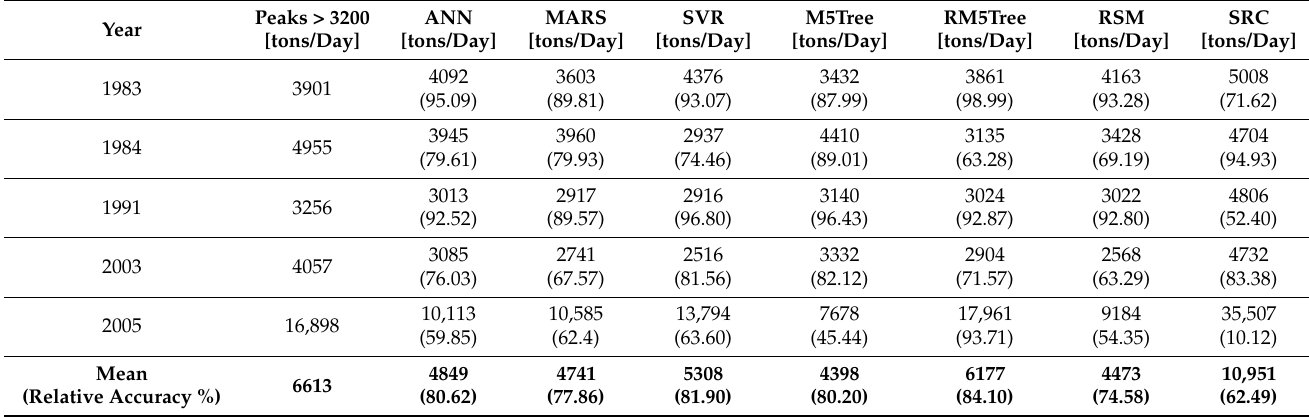
Table 11. Comparison of the ANN, MARS, SVR, M5Tree, RM5Tree, RSM and SRC models’ abso- lute sediment fluxes and relative accuracies (%) for the peak estimations of the SSY for the Gilgit gauging